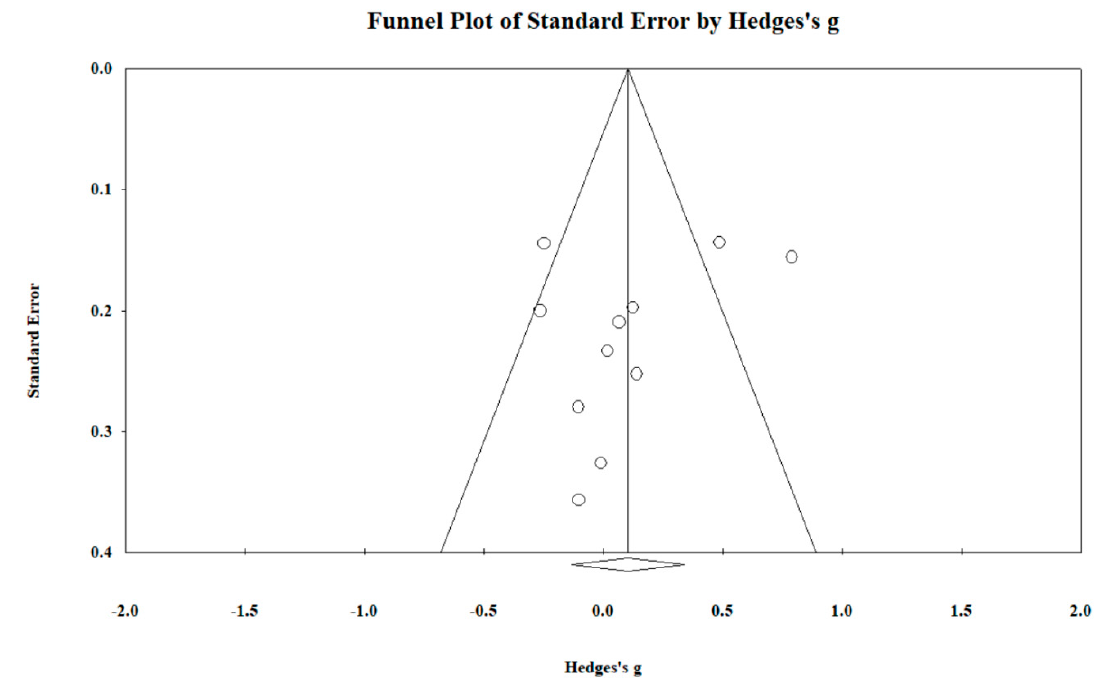
Figure A1. Funnel plot of Hedges’ g vs standard error for Stroop effect.